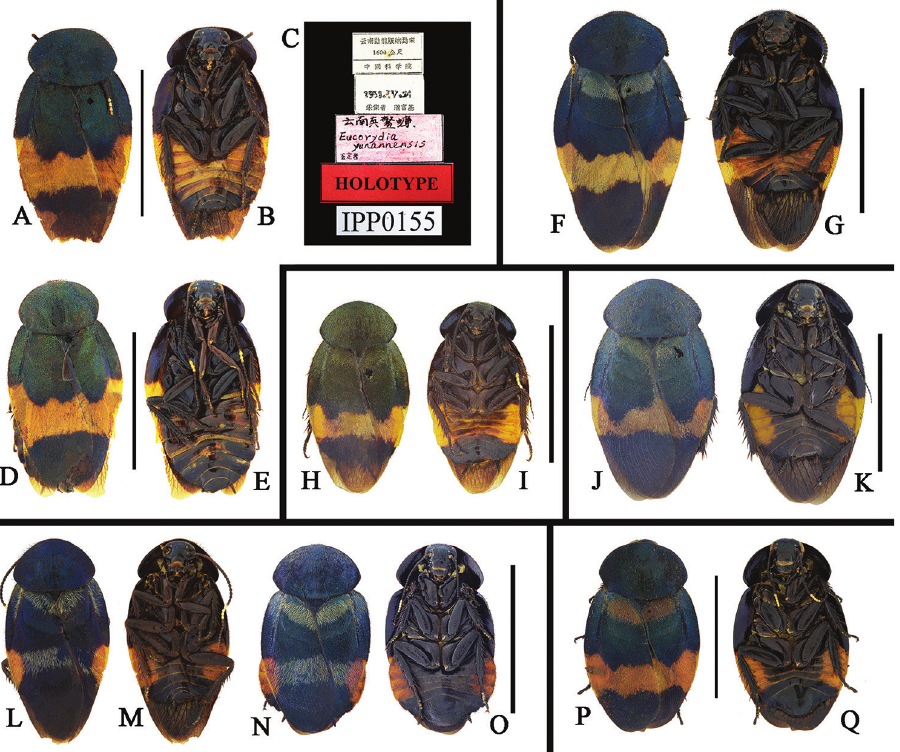
Figure 7. A–Q Eucorydia species from China A–E E. yunnanensis : A–C holotype, male D–E male, from Anshun, Guizhou F–G E. pilosa sp. n. male holotype from Xiaoheijiang, Yunnan H–I E.